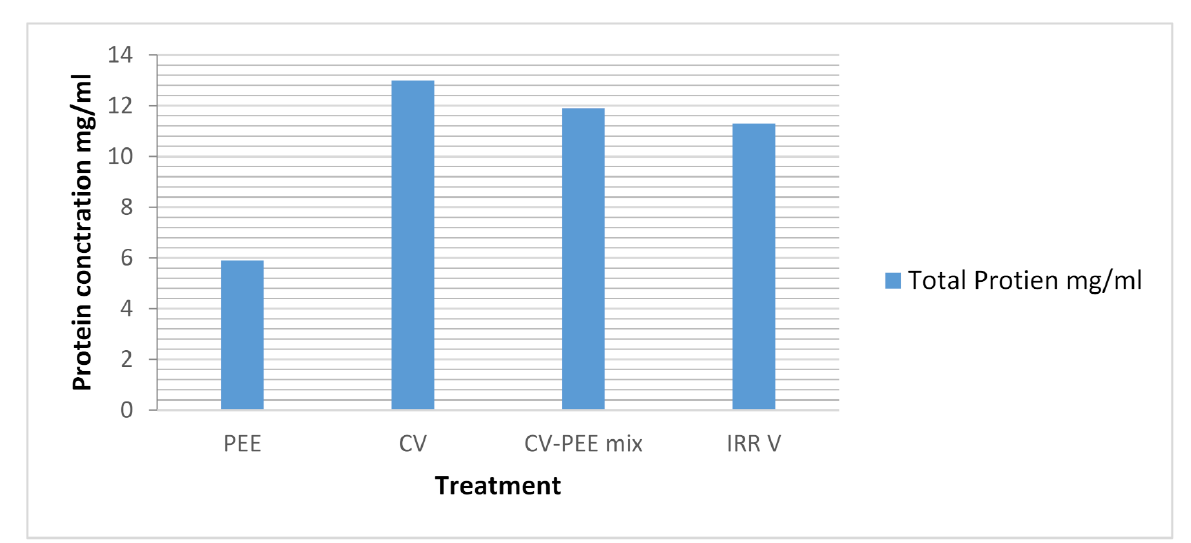
Figure 7. Evaluation of Total Protein of IRRV, CV-PEE Mix, CV and